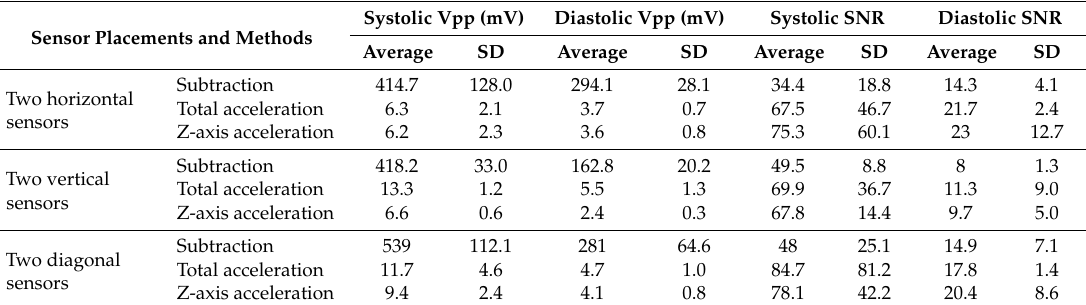
Sensor Placements and